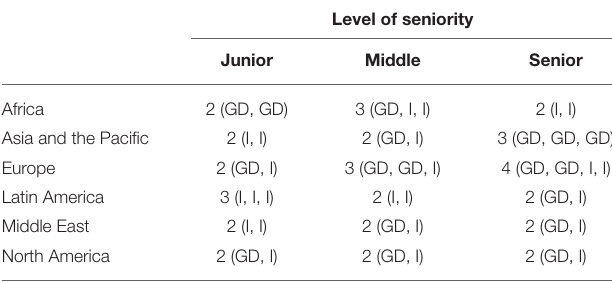
TABLE 1 | Composition of the